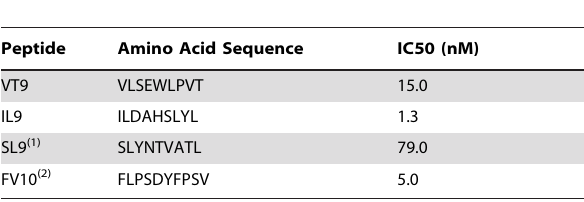
Table 3. Binding affinity of VT9 and IL9 to